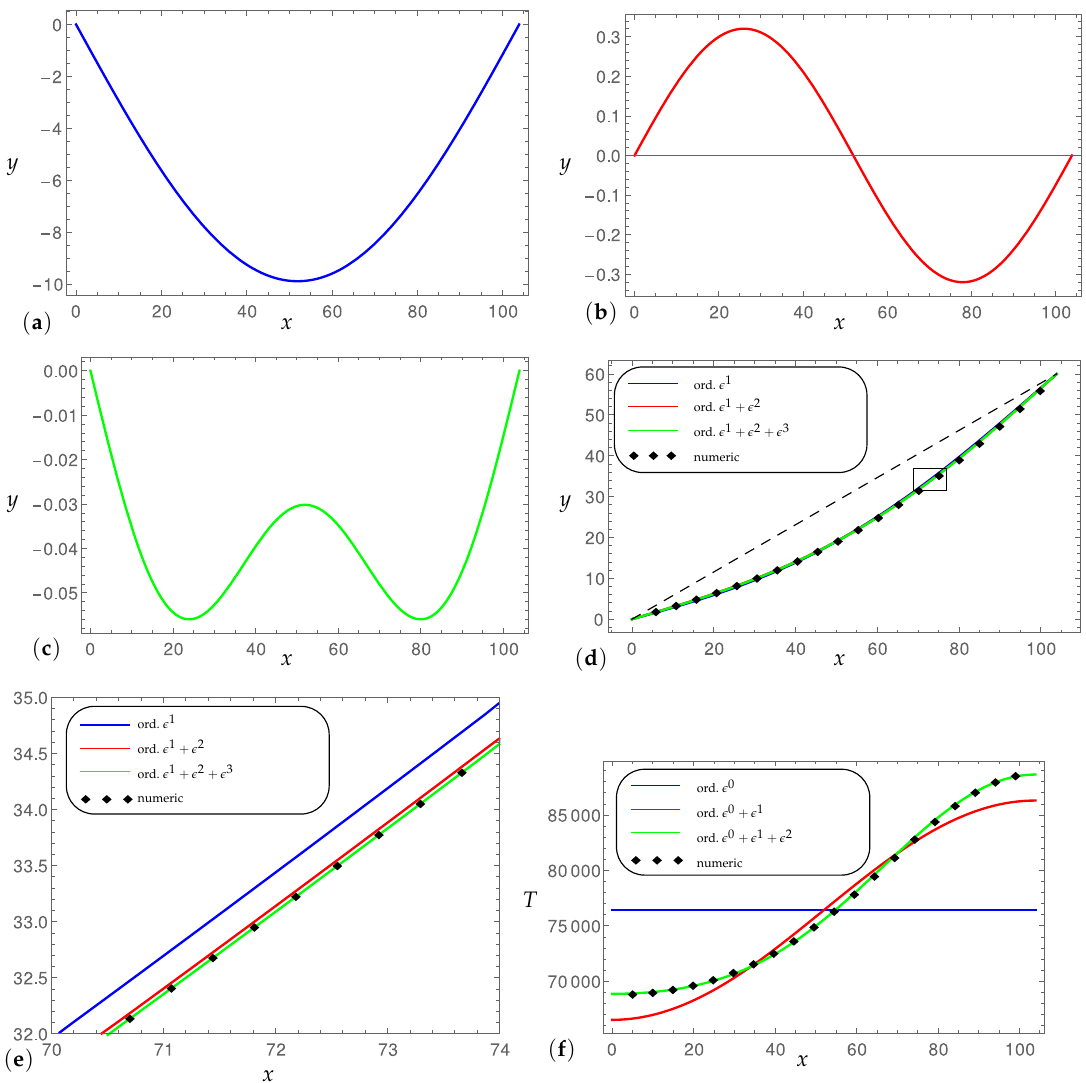
Figure 1. First case study: ( a ) solution y 1 ( x ) ; ( b ) solution y 2 ( x ) ; ( c ) solution y 3 ( x ) ; ( d ) reconstituted cable configuration (dashed line: the chord; the box indicates the boundaries of ( e )); ( e ) zoom of the reconstituted cable configuration; ( f ) normal force T ( x ) ; [ x , y ] = m ; [ T ] = N